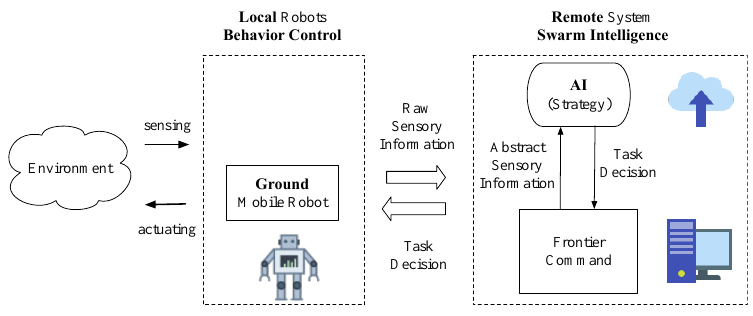
Figure 2. System: Remote swarm AI and local robotic behavior control.